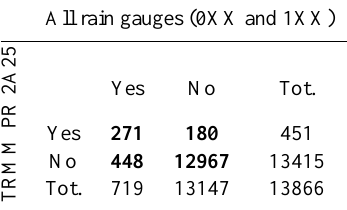
Table 1. Contingency table for TRMM 2A25 surface rain rate and 10-min rain gauge rain rates. The 10-min time scale is centered over the time the satellite